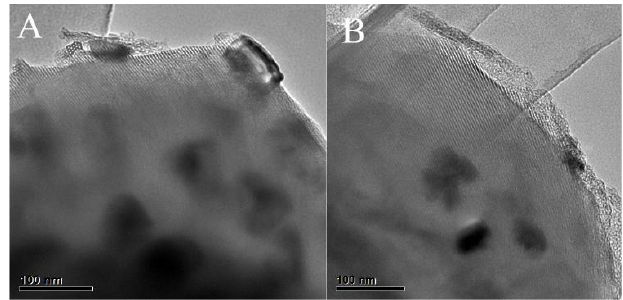
Figure 10. The TEM images of spent 10%Ni / MCM-41 ( A ) and spent 10%Ni-MCM-41 ( B ).